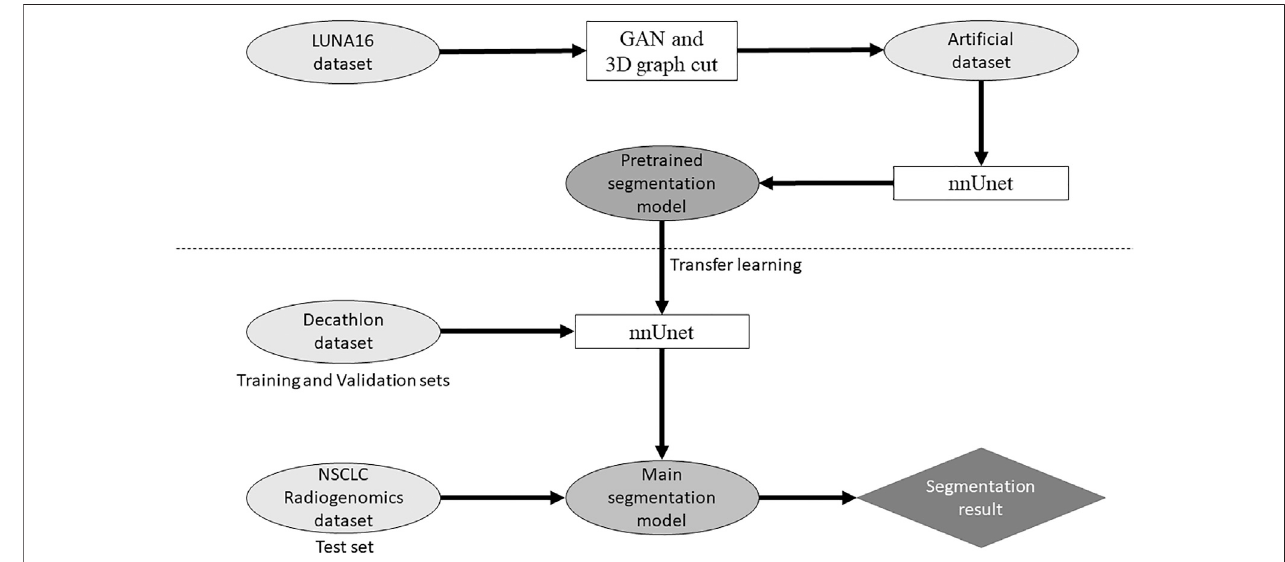
FIGURE 1 | Outline of the proposed method for the segmentation model.